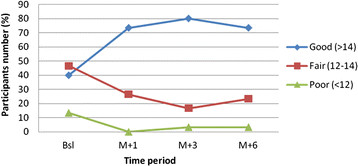
Distribution of CBIA-DM participants in knowledge levels.